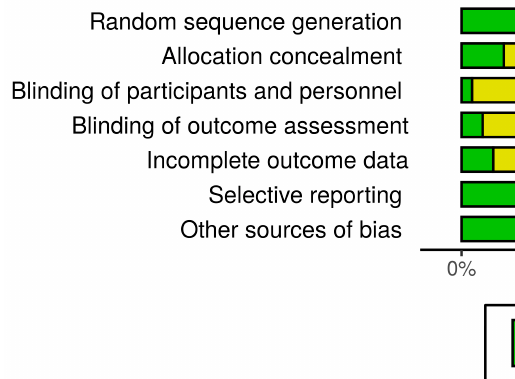
SYRCLE’s RoB tool for animal studies. The bars represent the percentage of articles found in each category. Other sources of